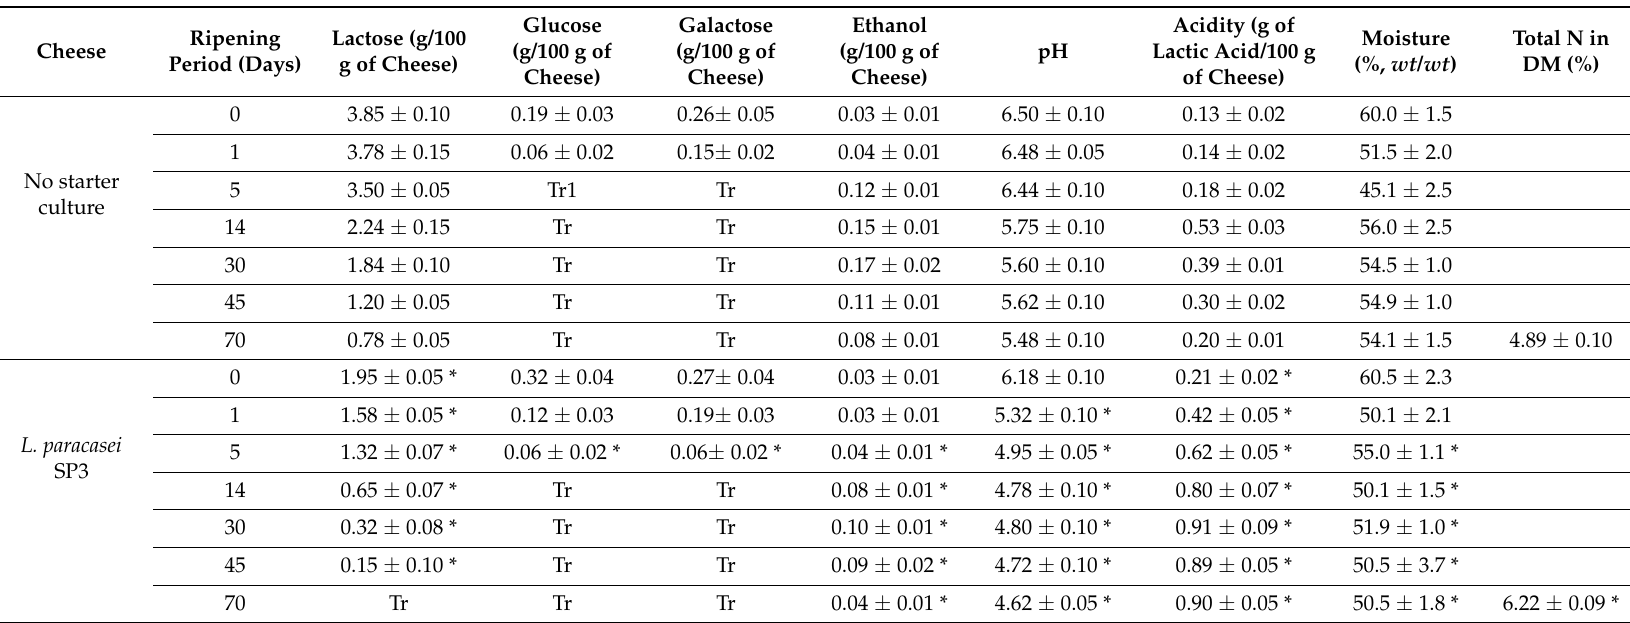
Table 3. Effect of Lactobacillus paracasei SP3 on physicochemical characteristics and sensory attributes of Feta-type